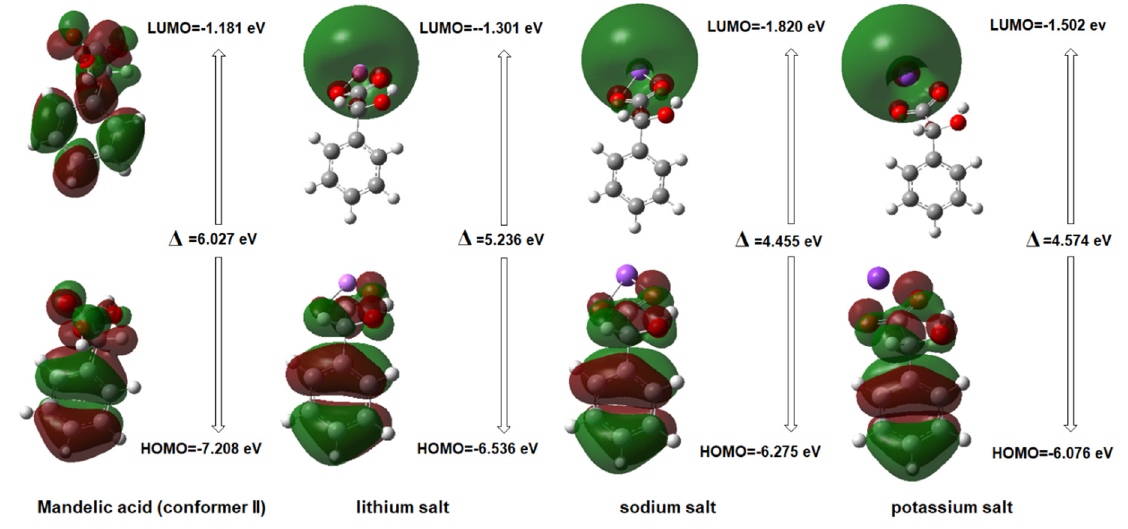
Figure 3. Shape and position of the HOMO and LUMO orbitals in the analyzed molecules.